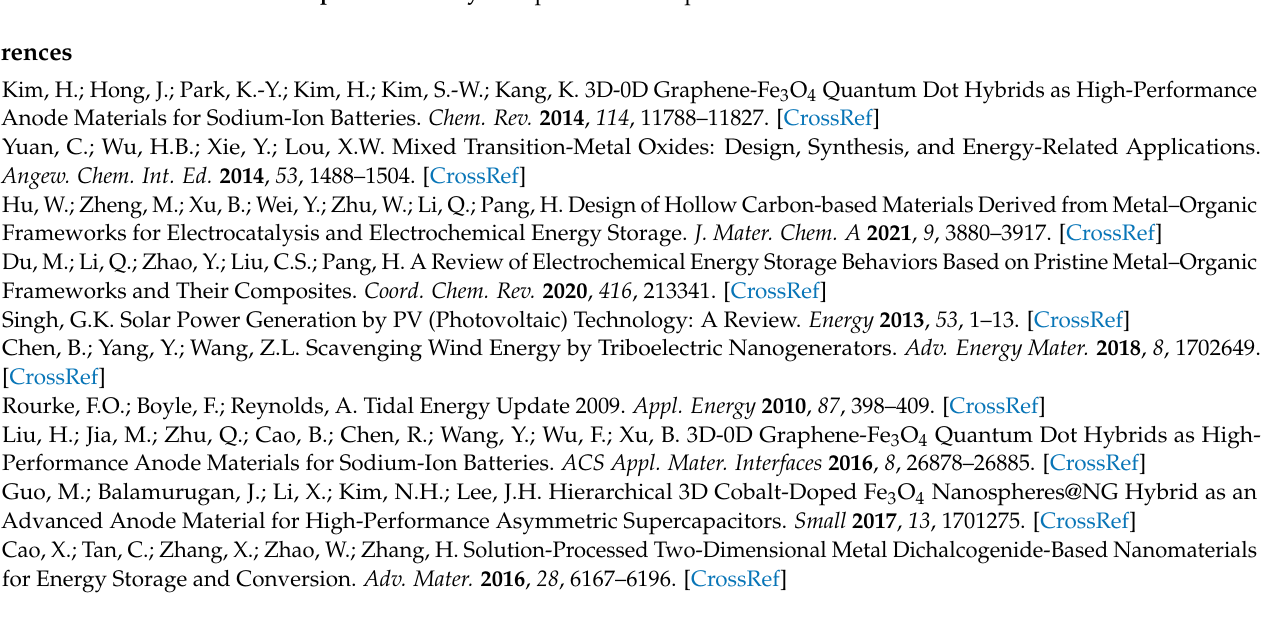
Figure S6. (a) Cyclic voltammetry curves of the first three cycles of cubic Fe 2 O 3 ; (b) Representative charge-discharge curves of cubic Fe 2 O 3 ; Figure S7. (a) Cyclic voltammetry curves of Fe 3 O 4 @void@N- composite; Figure S8. (a) Cyclic voltammetry curves of Fe 3 O 4 @void@N-Doped C-10